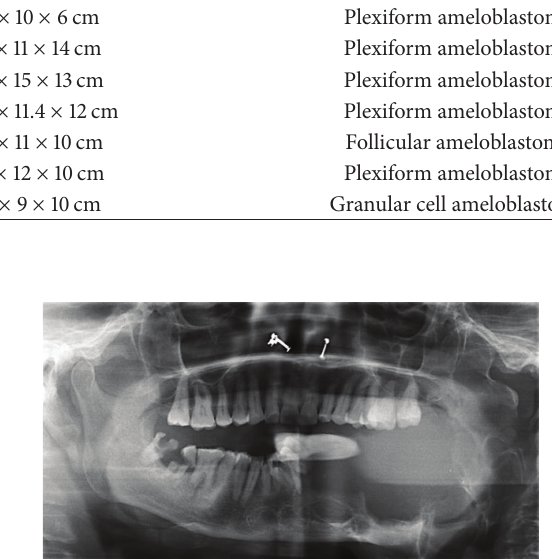
Figure 2: Radiographic examination revealed a multilocular radi- olucency, extending from left condyle and coronoid process to right central and lateral incisors with thinning of lower border of man- dible.